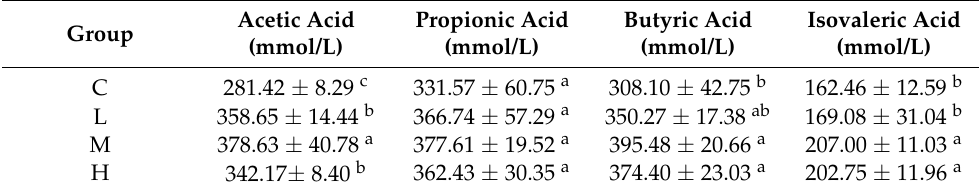
Table 4. SCFAs production of mice after treatments of FRJ.